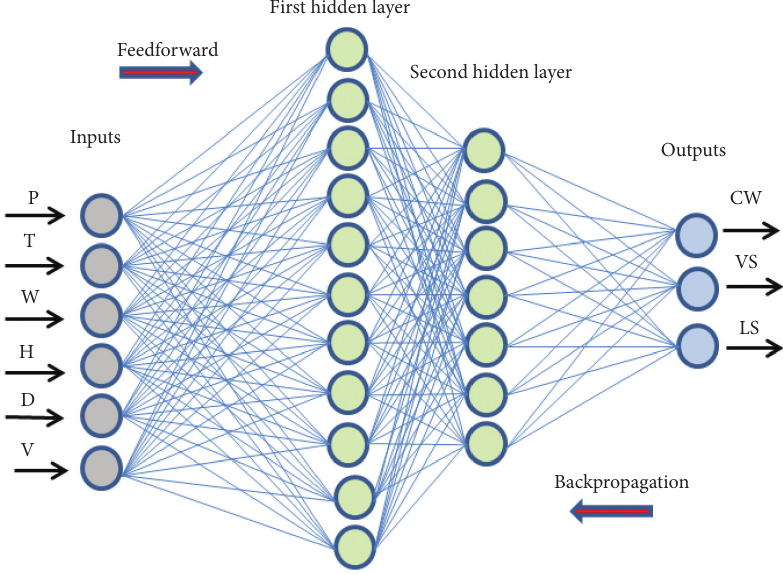
Figure 16: A schematic view of the attained ANN structure in this study. Table 9: The optimal ANN parameters for outputs (CW, VS, and LS).